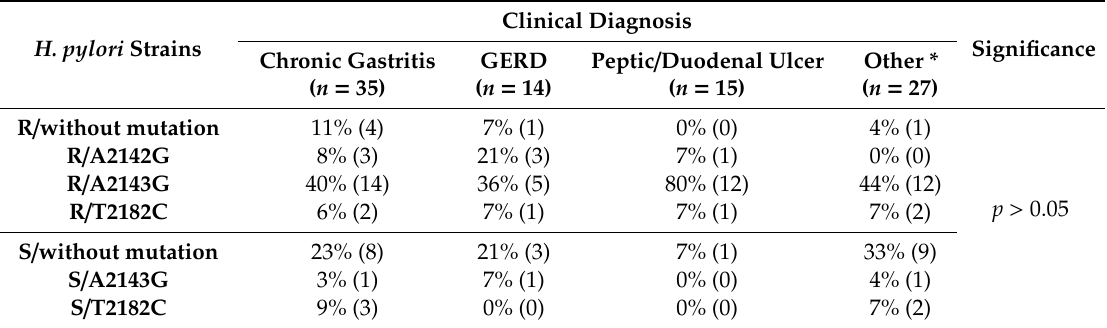
Table 2. The occurrence of point mutations in the 23S rRNA gene in H. pylori strains depending on the clinical diagnosis.